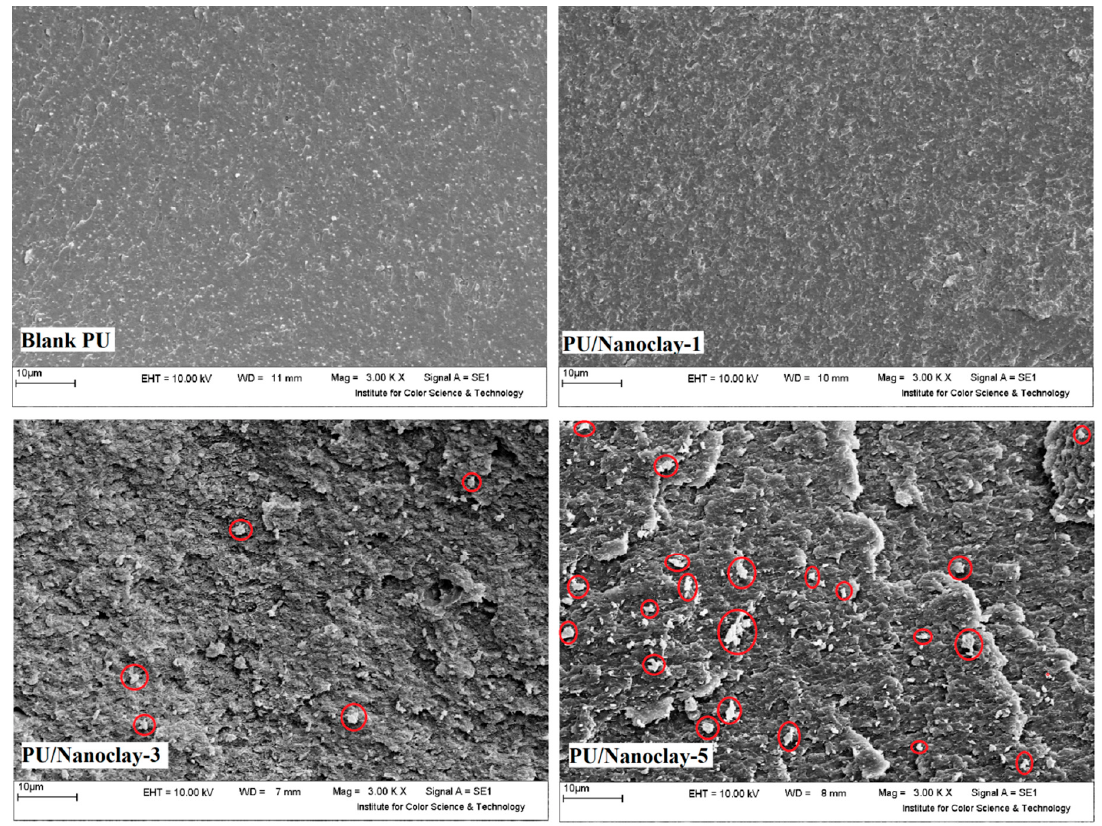
Figure 1. SEM micrographs of blank PU and its nanocomposites containing 1, 3, and 5 wt.% of nano-clay. Red circles show the nano-clay agglomeration.